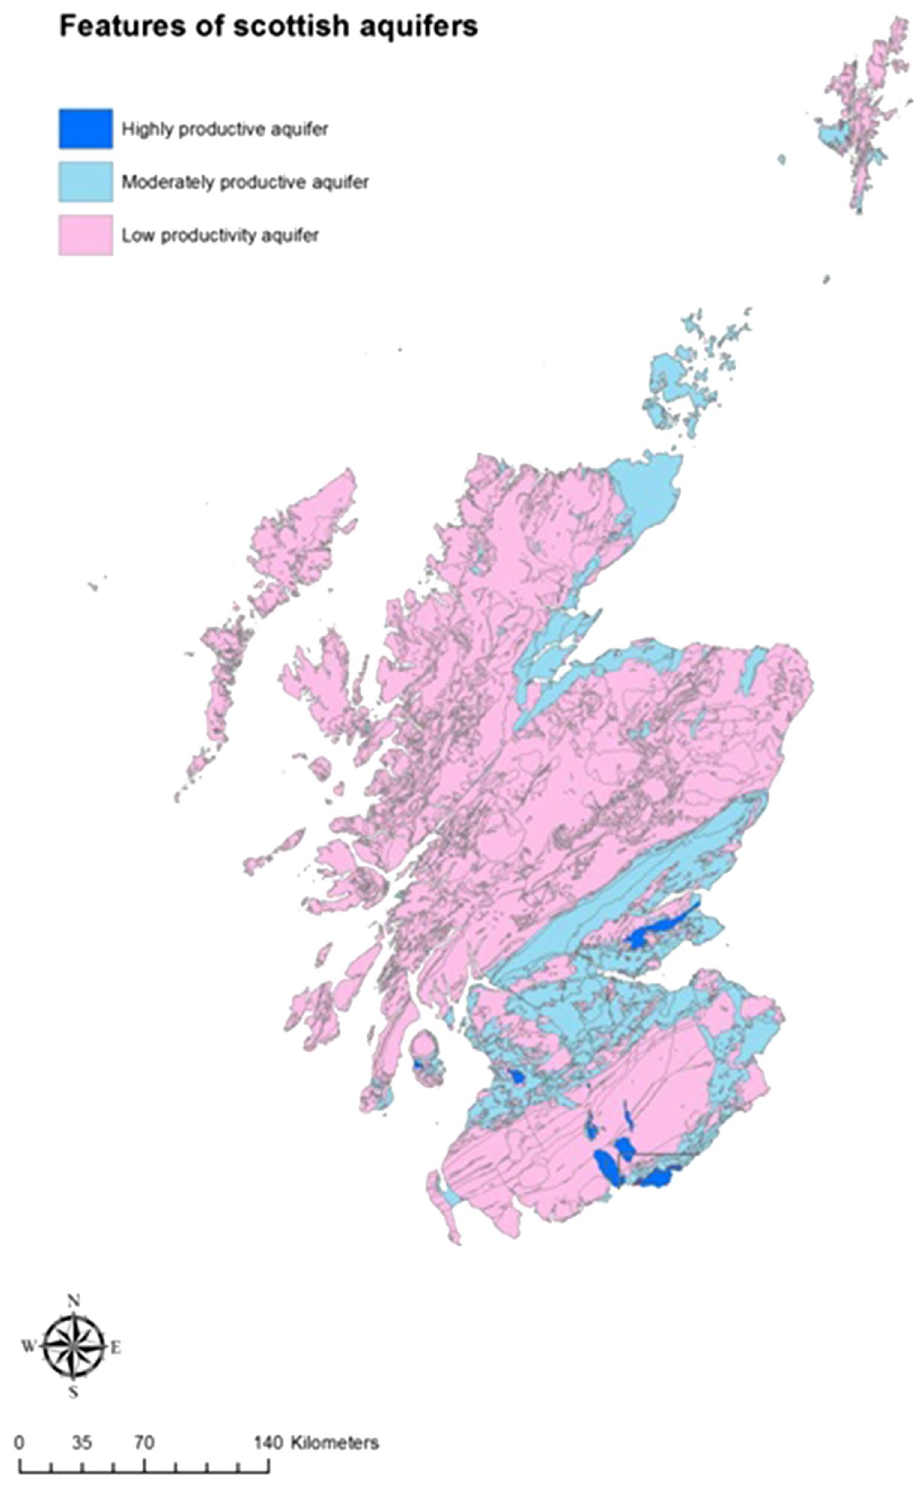
Fig. 2 Characteristics of the Scottish